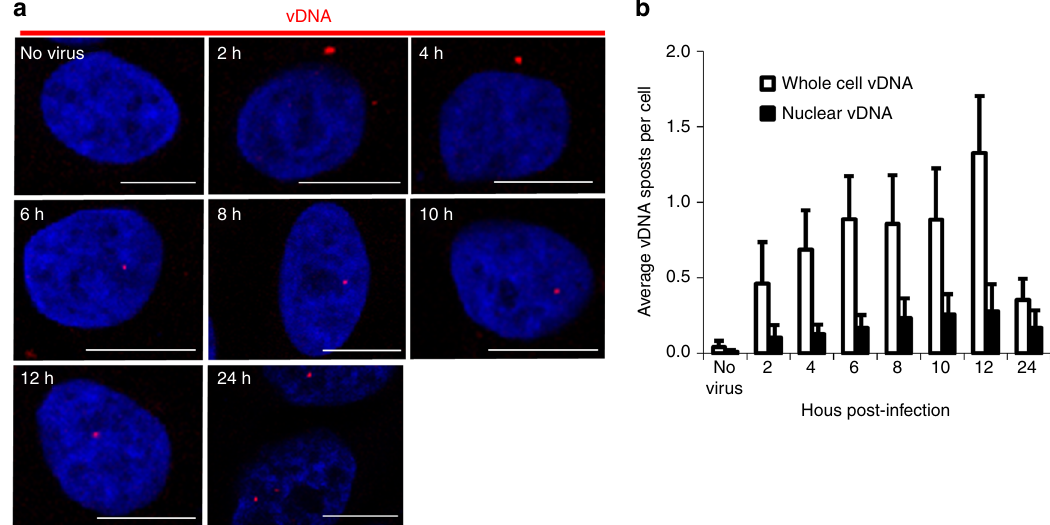
Fig. 3 Time course of vDNA detection. a TZM-bl cells were infected with HIV-1 at an MOI of ~0.2; at indicated times, cells were fi xed and stained for vDNA (PS-3; red) and nuclei (blue). Scale bars represent 10 µ m. b Foci of vDNA were counted in 300 – 340 cells per time point, using Gen5 software. The average number of vDNA foci per cell was calculated and shown in the graph with standard deviation indicated ( n = 3 independent experiments, except for 24 h time point, where n = 2)